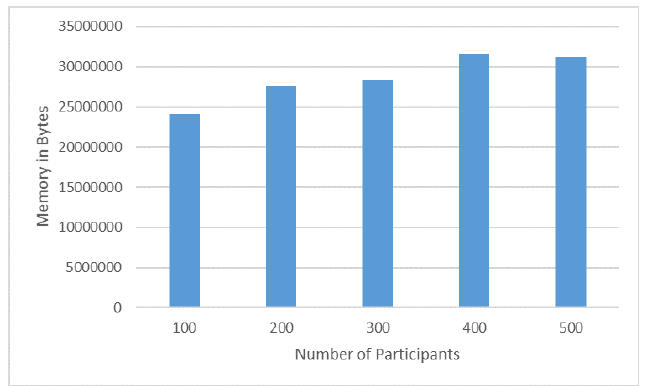
Figure 8. Graph showing the relationship between participant size and mean memory consumption for increasing group